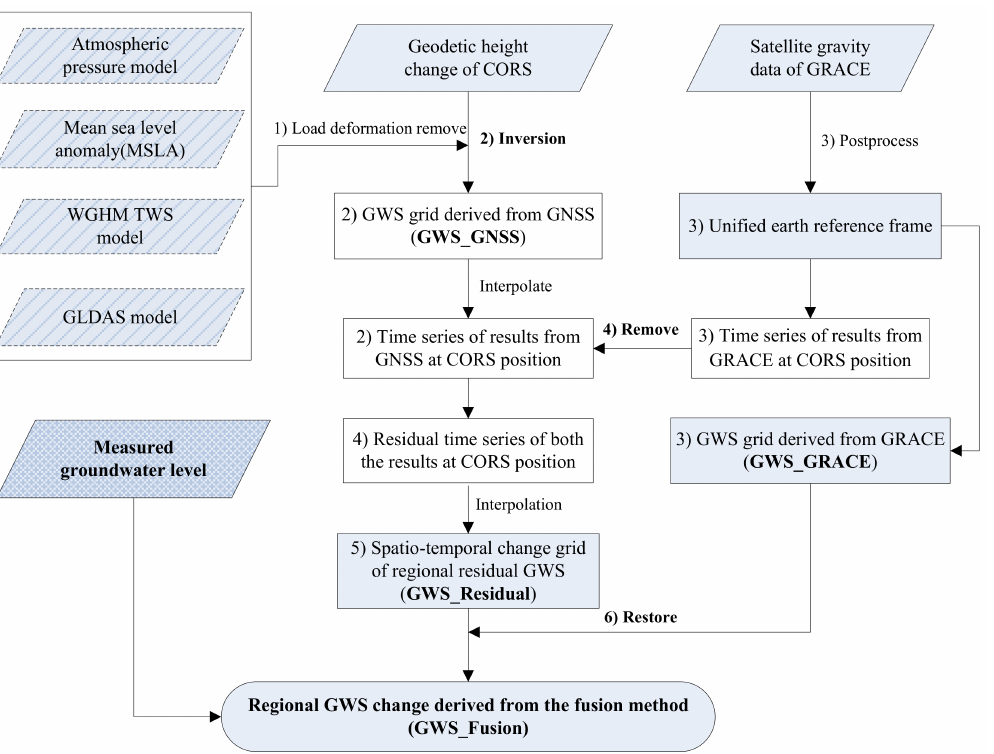
Figure 2. Method flow of regional GWS variation derived from the fusion of GNSS and GRACE data.